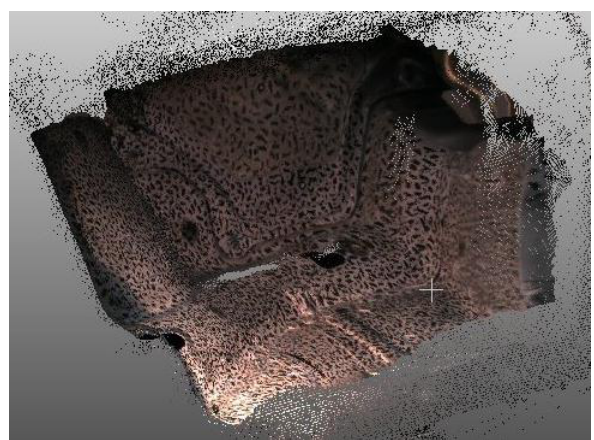
Figure 8. Coloured point cloud overlayed with dense monoplotting result of a footwell